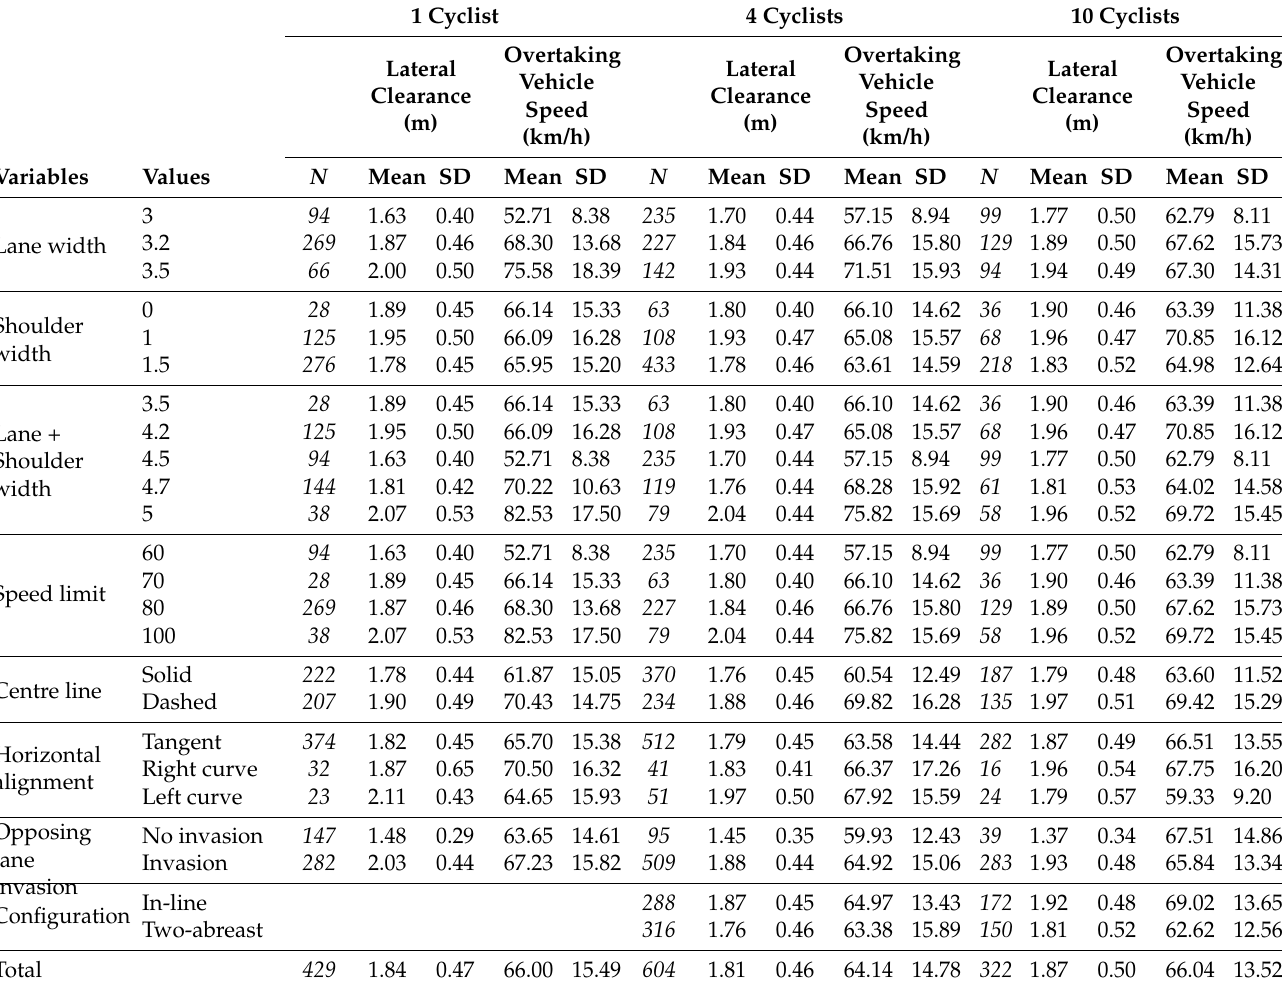
Table 2. Lateral clearance and overtaking vehicle speed results from field